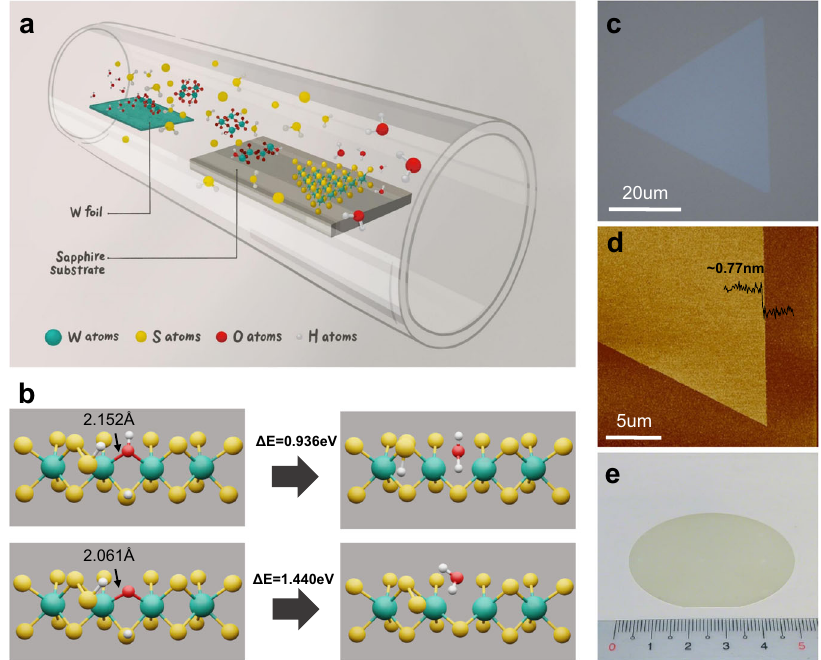
Fig. 1 Hydroxide Vapor Phase Deposition. a Schematic of hydroxide vapor phase deposition (OHVPD) growth of WS 2 monolayers. b Nudged elastic band (NEB) simulation of kinetic energy barriers ( Δ E) for bonded OH and O dissociating from the edge of WS 2 . c , d Optical Image c and AFM image d of the OHVPD-WS 2 monolayer. e Photo of a 2-inch OHVPD-WS 2 monolayer fi lm grown on a sapphire